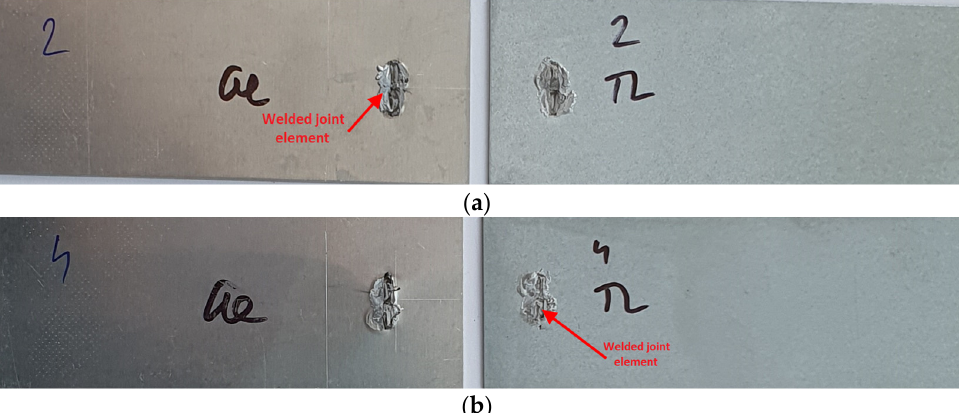
Figure 8. Fracture surfaces of some Al-TL test joints after tensile shear test: ( a ) sample 2 and ( b ) sample 4. ( b ) sample 4.